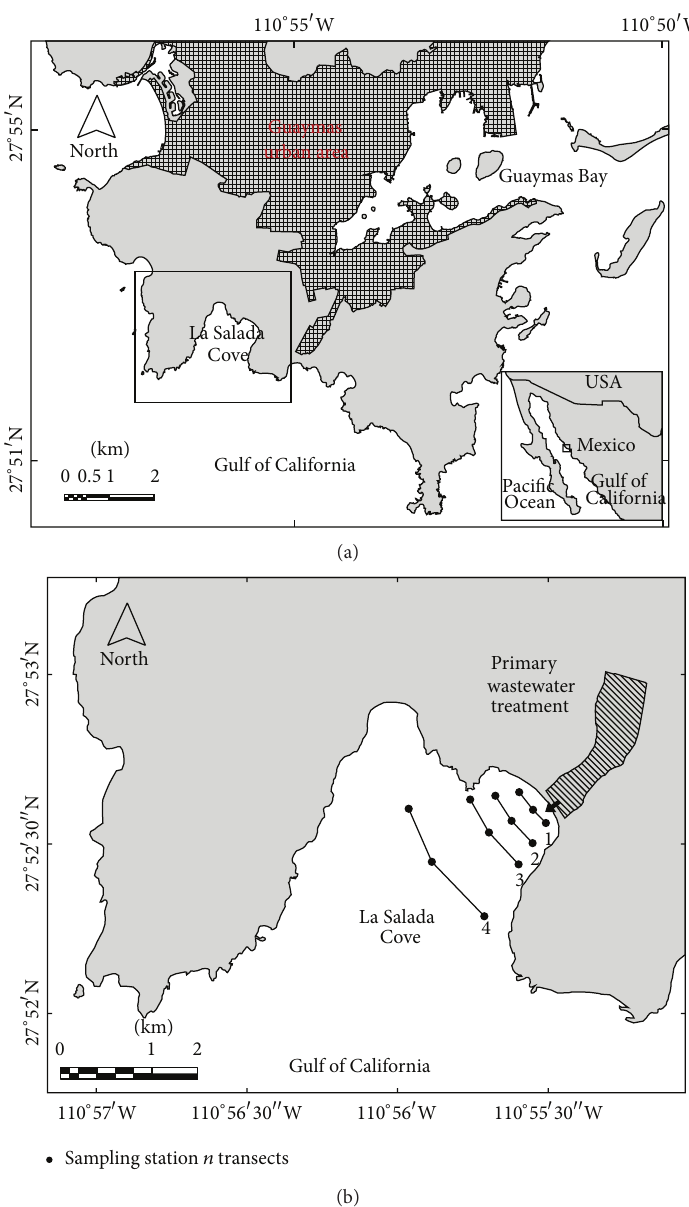
Figure 1: La Salada Cove, including urban area from Guaymas city and showing sampling stations and